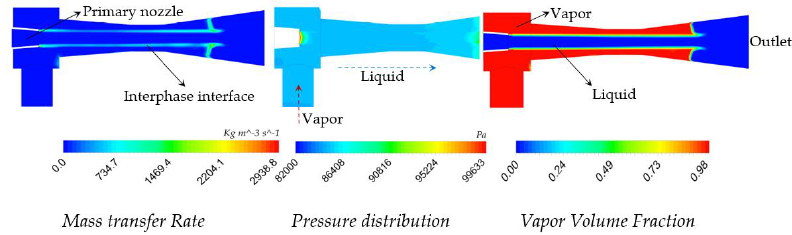
Figure 2. Two phase flow inside eductor.